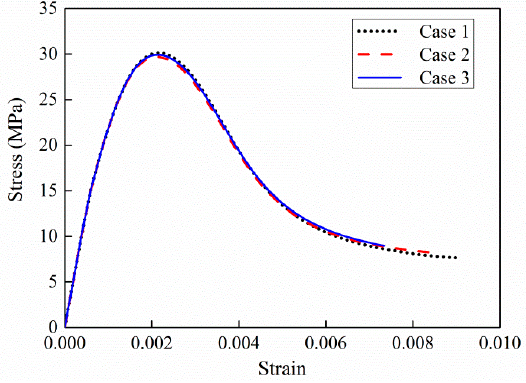
Figure 17. Comparison of different size distributions under uniaxial compression.